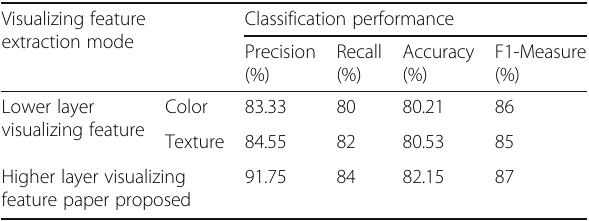
Table 1 Classification performance comparative results in two kinds of different target objects Visualizing feature extraction